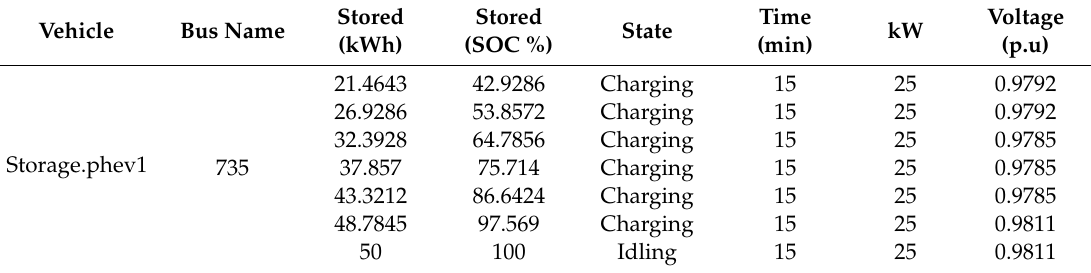
Table 6. Charging characteristics of a selected vehicle with a medium priority level.